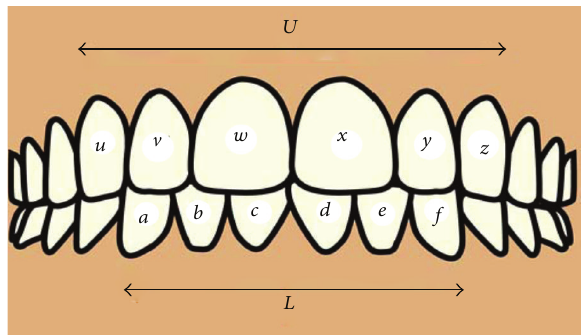
Figure 1: Showing anterior teeth and values required to calculate anterior